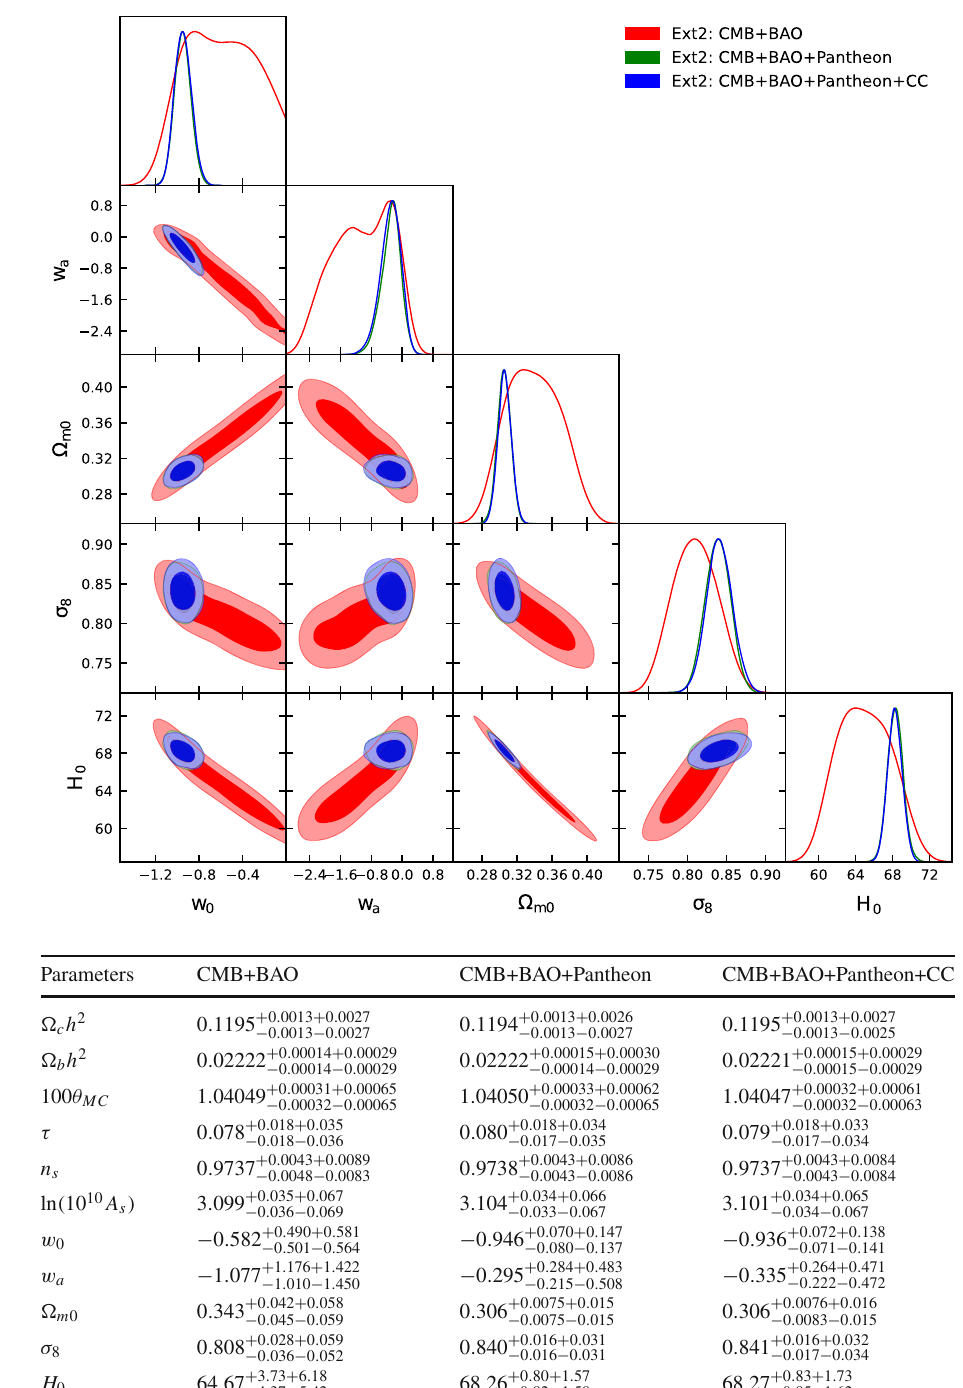
constraints on the dark energy parametrization, namely, the Ext3 of (9) using various observational datasets. We note that H 0 is in the units of km/Mpc/sec and (cid:12) m 0 is the present value of (cid:12) m = (cid:12) b + (cid:12)